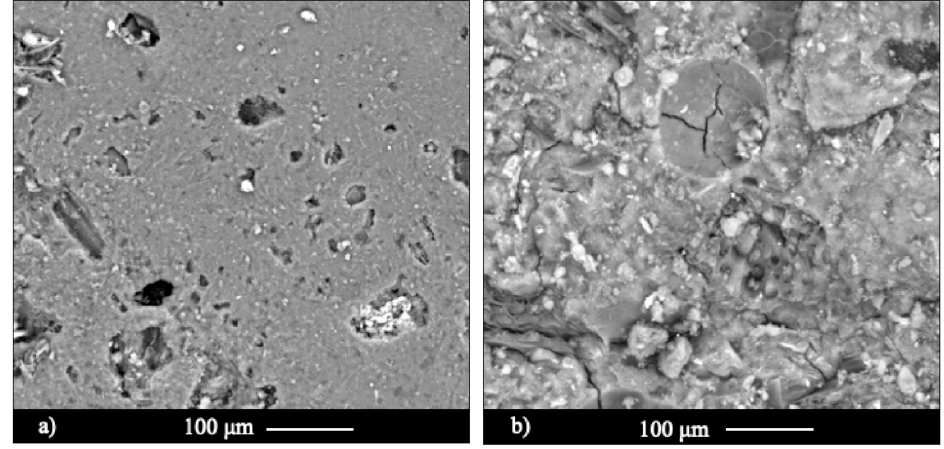
Figure 11. External ( a ) and internal ( b ) surface of SERIES 3 where MK is replaced by